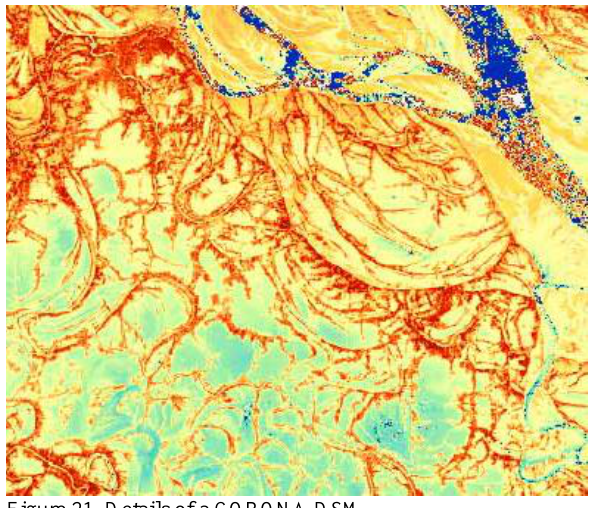
Figure 21. Details of a CORONA